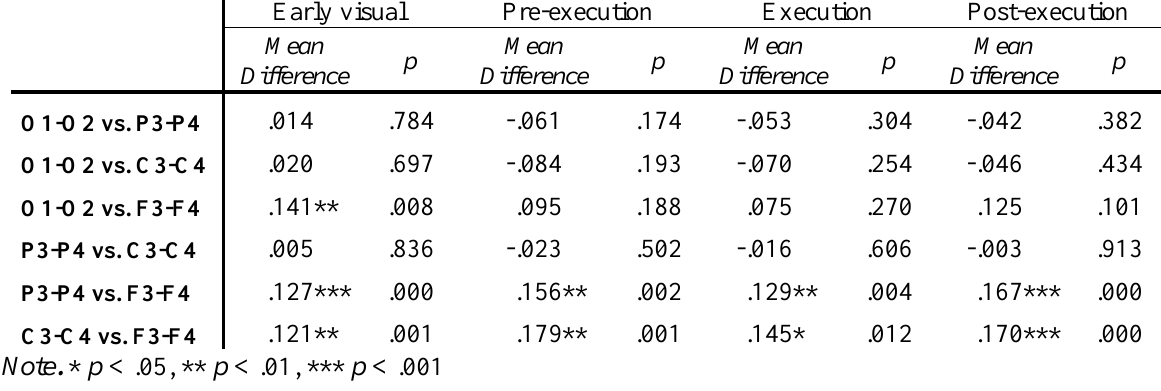
Table 6. LSD post hoc tests applied to compare the difference of coherence strength between anterior posterior inter hemispheric electrode pairs.